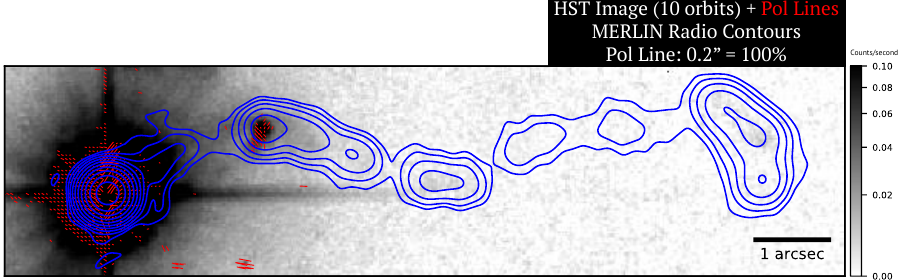
Figure 2. Optical ( HST /ACS + F606W) Stokes I image of the nucleus and jet of 1150+497 is shown, with radio 1.66 GHz contours from Multi-Element Radio Linked Interferometer Network (MERLIN) observations in blue and optical polarization E-field vectors overlaid in red. We have filtered polarization vectors by showing only pixels with optical polarization SNR > 4.0. Polarization vectors are of scale 0.2 arcsec = 100% polarization. Radio contours increase by factors of two. Only one polarized jet region is seen, with other regions falling below the detection limit. The greyscale is at far right. See text for